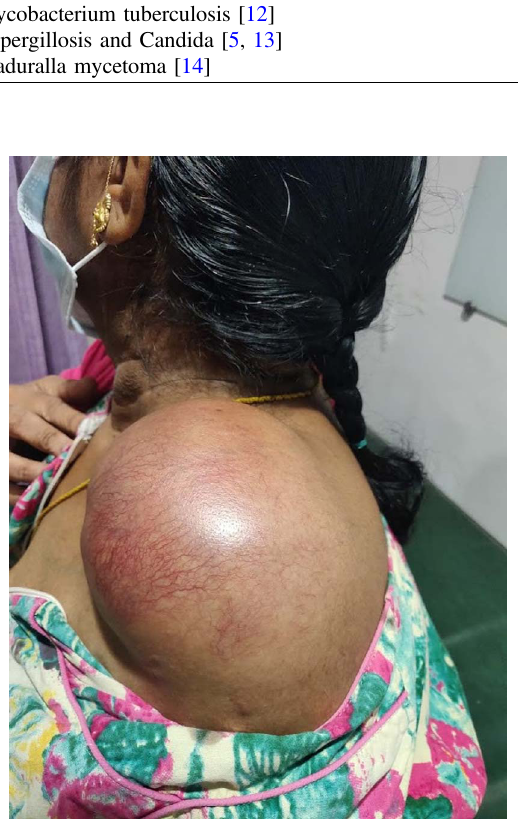
Figure 1. Clinical photograph of swelling over left shoulder.